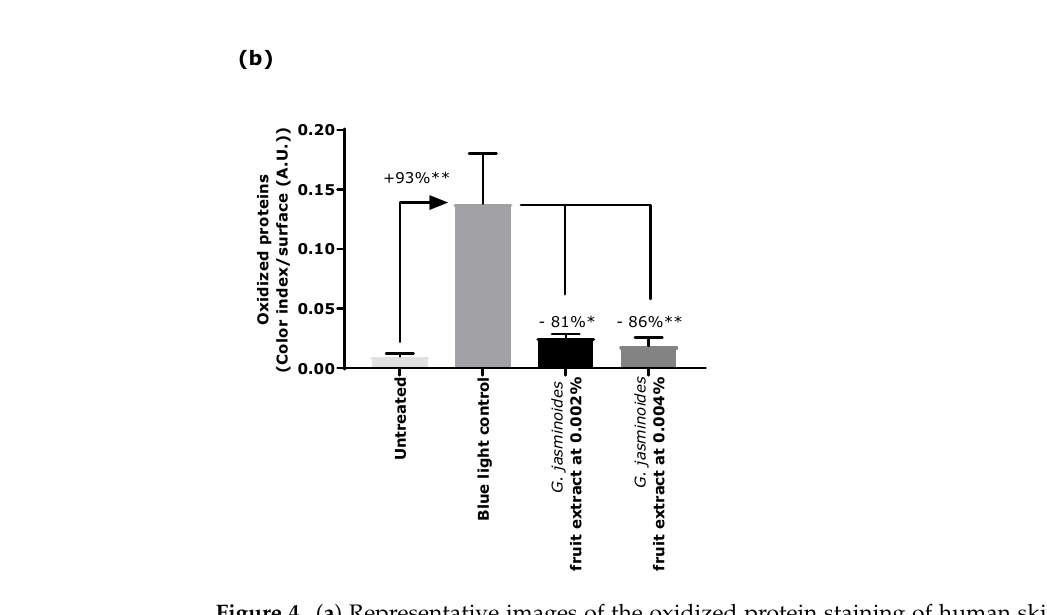
Figure 5. Quantification of melatonin release in the co-culture medium of cells exposed or not exposed to blue light stress (20 mJ/cm²). Statistical analysis with a Kruskal–Wallis ANOVA, followed by a Mann–Whitney U test in comparison to the blue light control, where * p < 0.05. Legend: D0 = Day 0; D1 = Day 1; D2 = day 2.